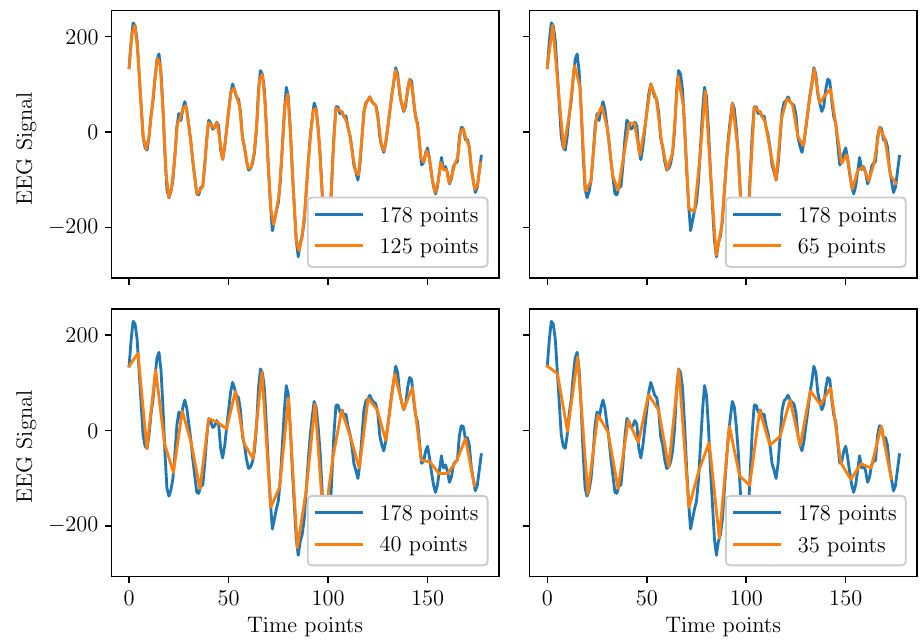
Figure 2. Comparison between the downsampled and the original EEG